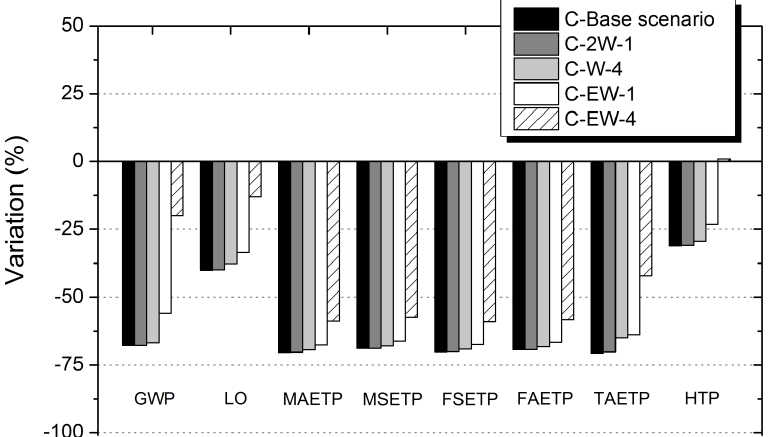
Figure 4. The change in the potential environmental impacts of the continuous process in comparison with the batch production scheme varying the cleaning agent